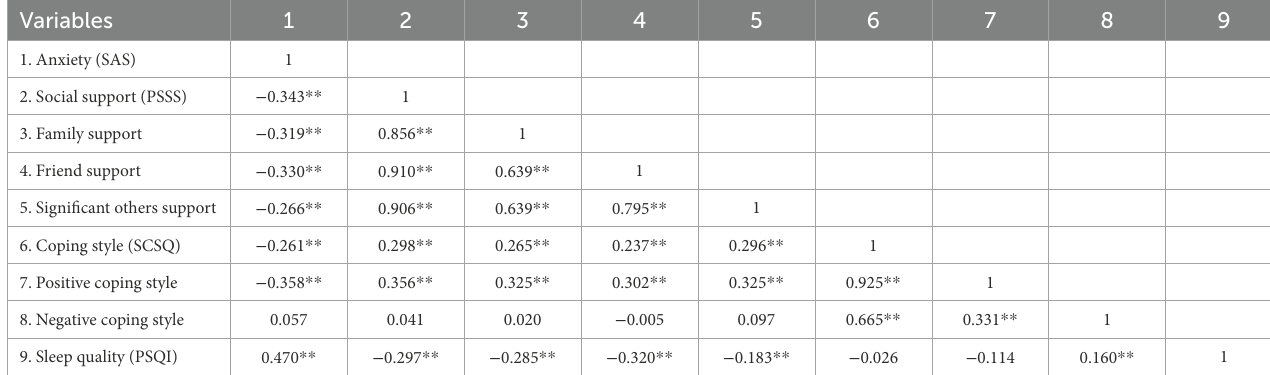
TABLE 3 Correlation analysis. Variables